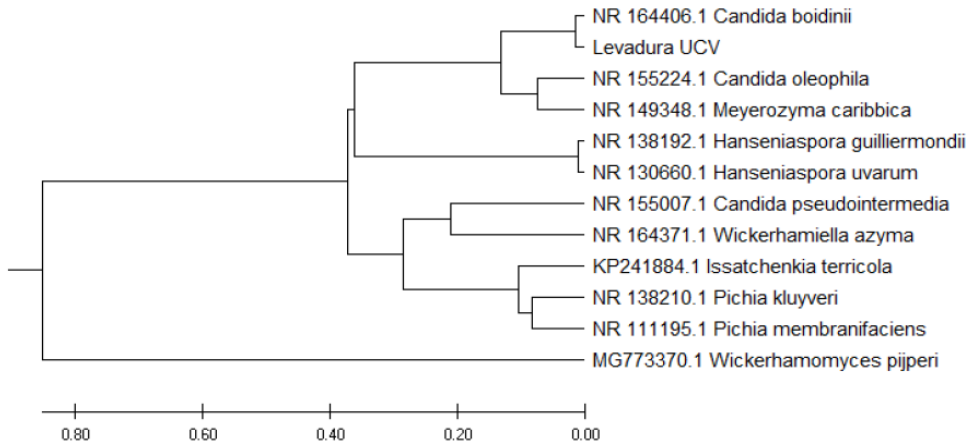
Figure 5. Dendrogram based on the ITS regions of the rDNA regions of a C. boidinii culture isolated from the anode plate of MFC.